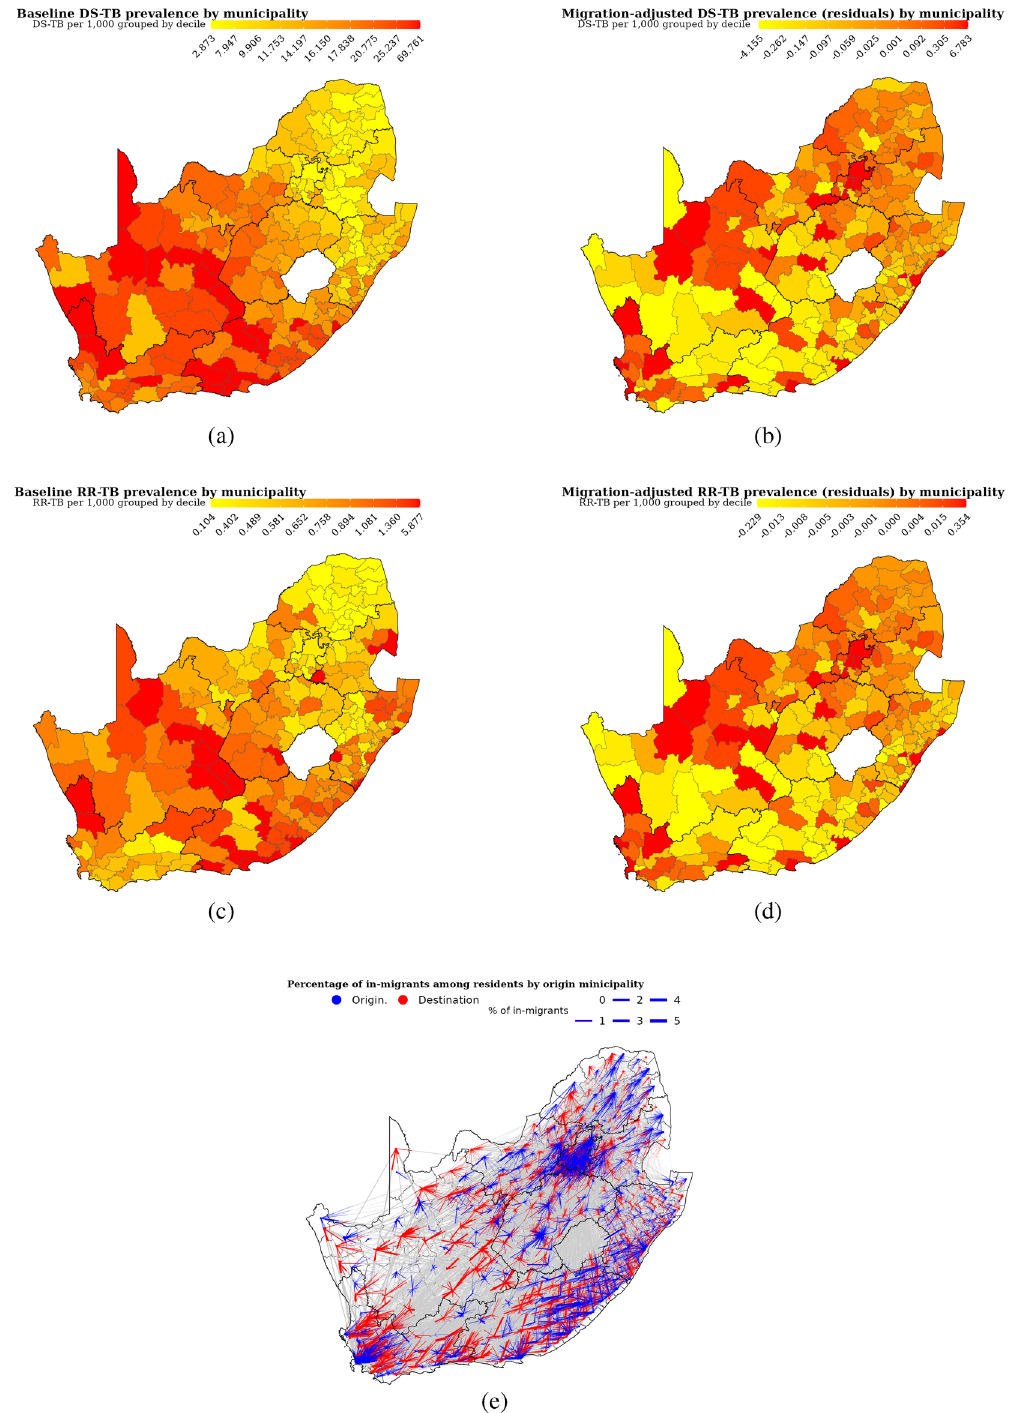
Figure 3. Baseline drug-susceptible tuberculosis prevalence ( a ), migration-adjusted drug-susceptible prevalence ( b ), baseline rifampicin-resistant tuberculosis prevalence ( c ), migration-adjusted rifampicin-resistant tuberculosis prevalence ( d ) by municipality, and cross-municipality migration rates ( e ). Migration-adjusted prevalence was presented as the residuals (difference between migration-adjusted and baseline prevalence) which we estimated using municipality-level tuberculosis prevalence from South Africa’s National Health Laboratory Service database and cross-municipality migration rates from the 2016 South African Community